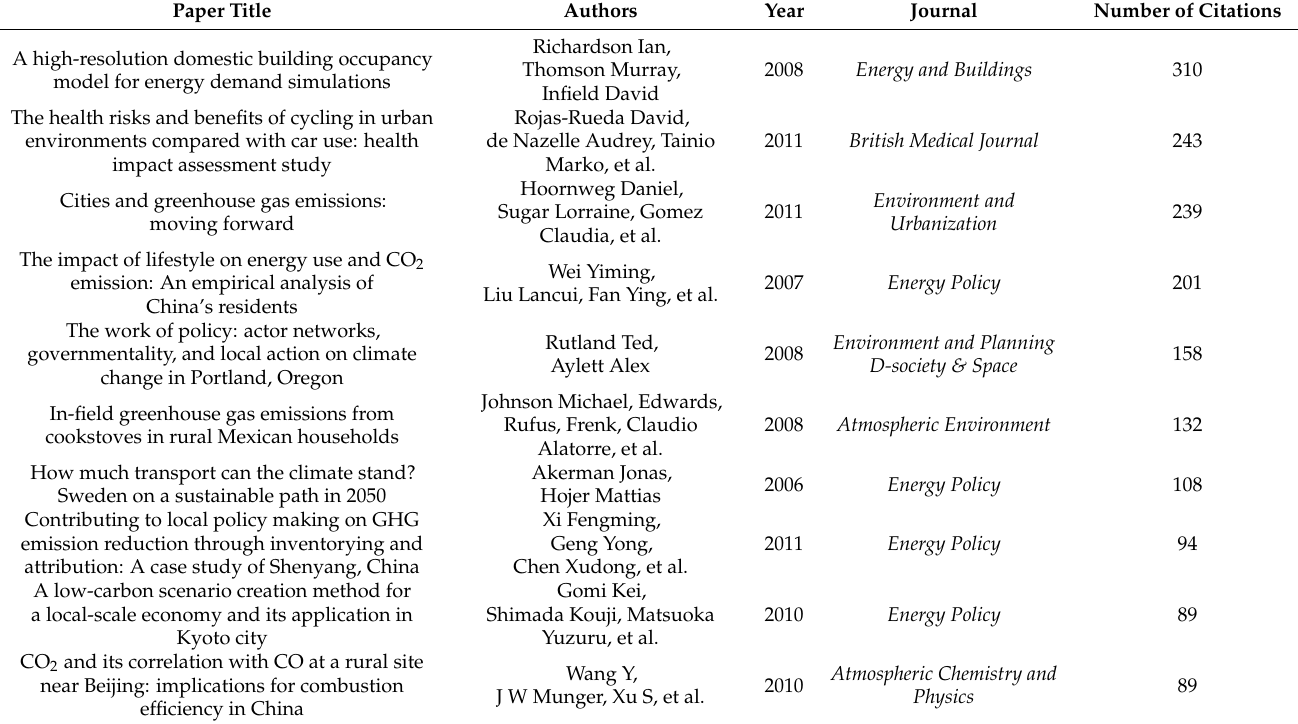
Table 1. Top 10 papers of cited number from 2000 to 2021 in Web of